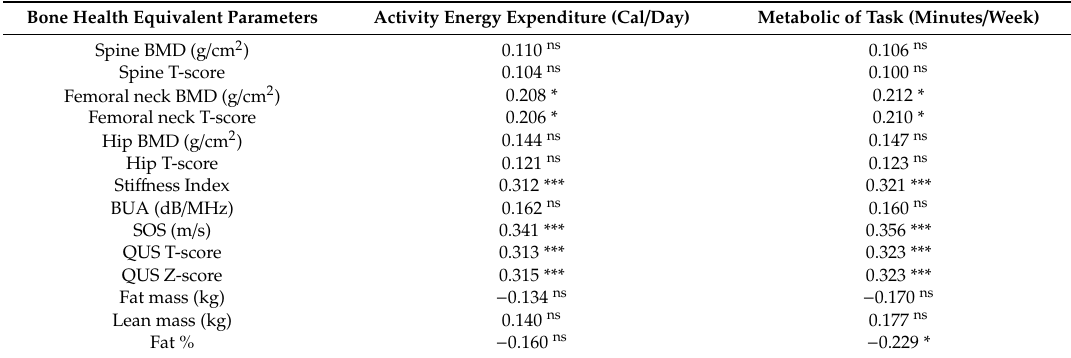
Table 3. The partial correlation coe ffi cients of bone health and quantitative ultrasound (QUS) parameters with PA measures adjusted for age, weight and